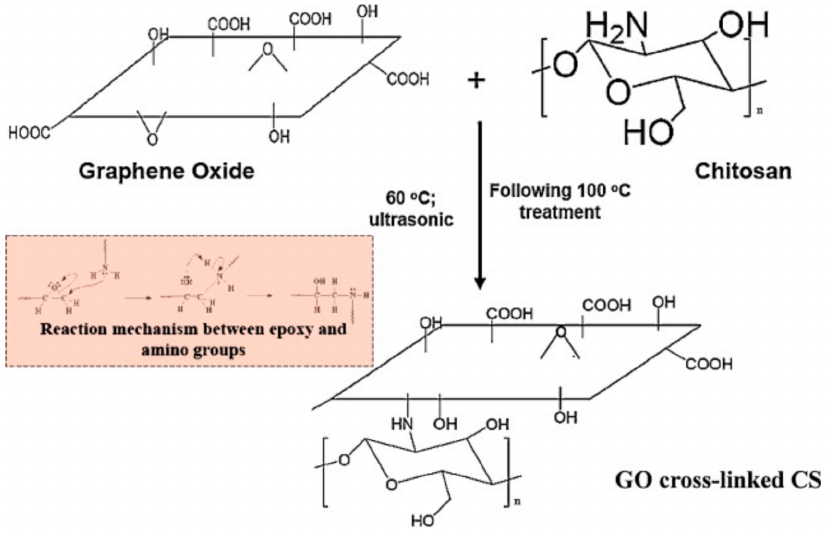
Figure 7. Cross-linking reaction between GO and CS to form nanocomposite membranes